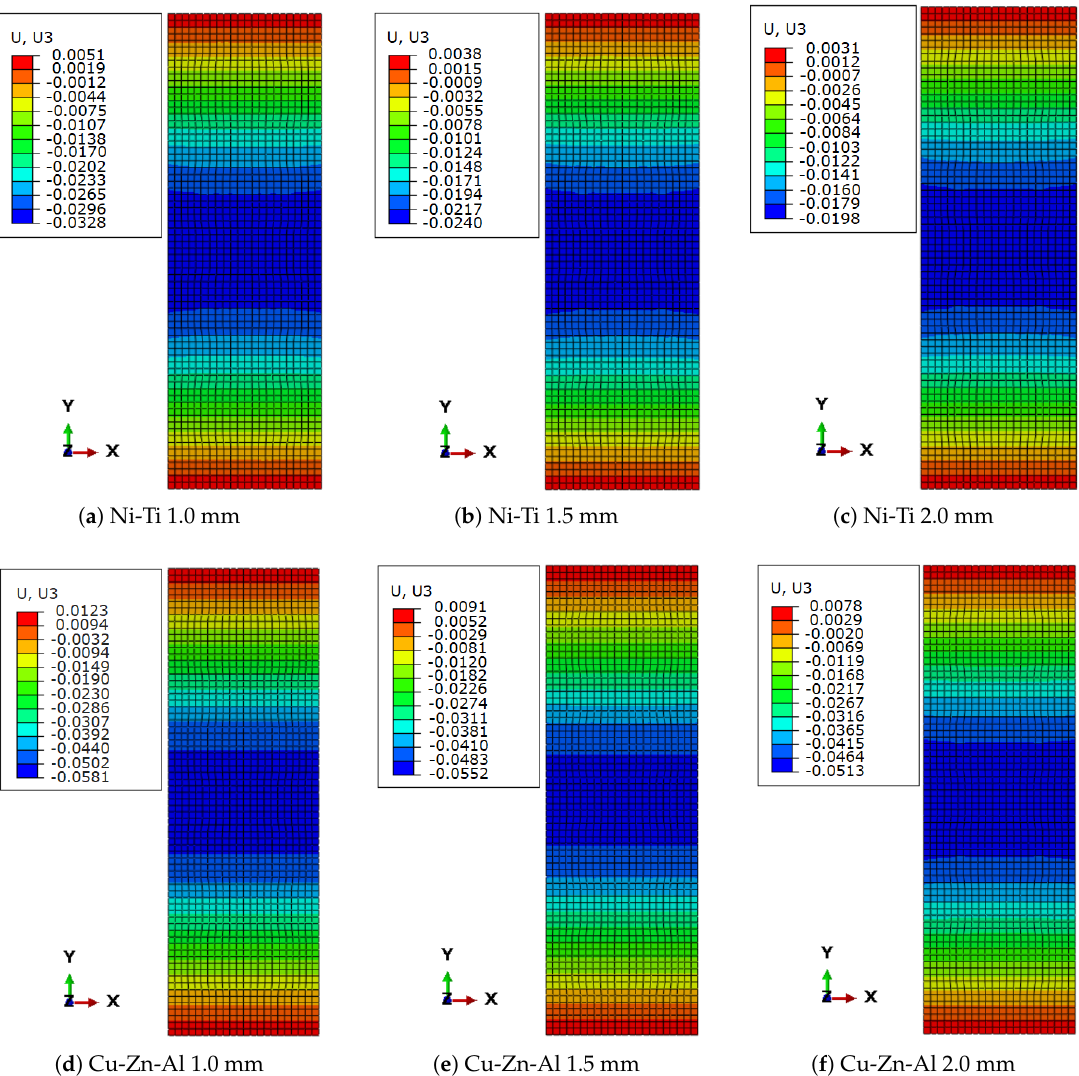
Figure 15. Residual displacement in the direction of loading (U 3 , U Z or out-of-plane) in retrofitted models: ( a ) 1.0 mm Ni-Ti; ( b ) 1.5 mm Ni-Ti; ( c ) 2.0 mm Ni-Ti; ( d ) 1.0 mm Cu-Zn-Al; ( e ) 1.5 mm Cu-Zn-Al; ( f ) 2.0 mm